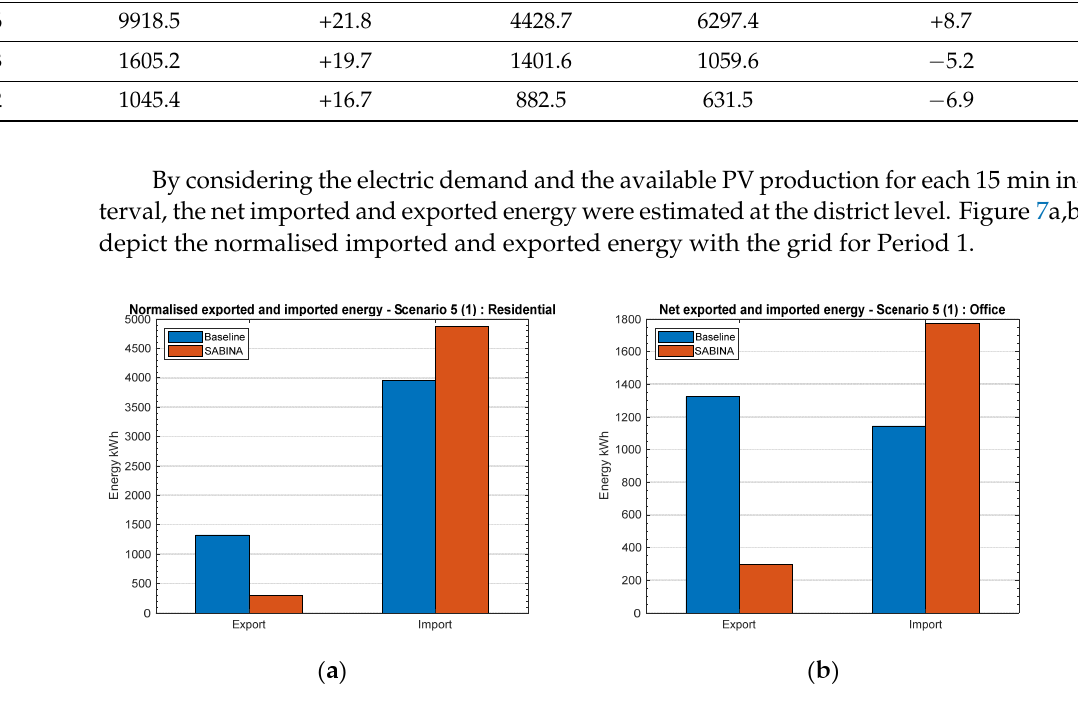
Figure 7. Normalised energy grid exchange: ( a ) residential (1); ( b ) office (1).